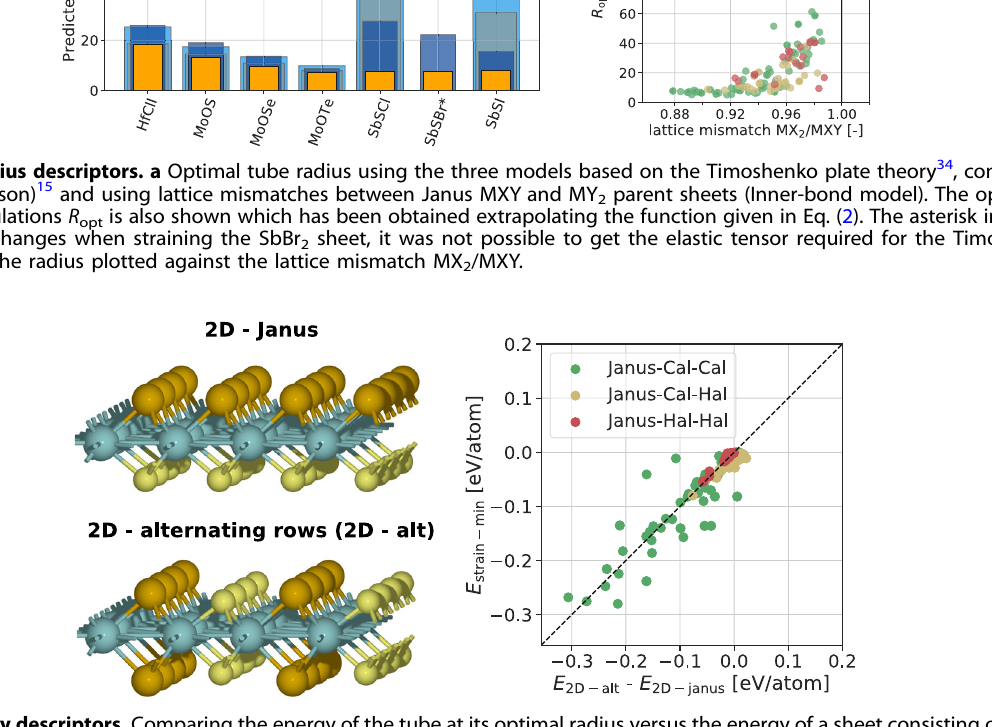
Fig. 8 Strain energy descriptors. Comparing the energy of the tube at its optimal radius versus the energy of a sheet consisting of alternating anion rows (2D-alternating rows prototype structure or 2D-alt). The mean average error for the different combinations are 22.9 meV/atom (Janus-Cal-Cal), 14.4 meV/atom (Janus-Cal-Hal) and 3.1 meV/atom